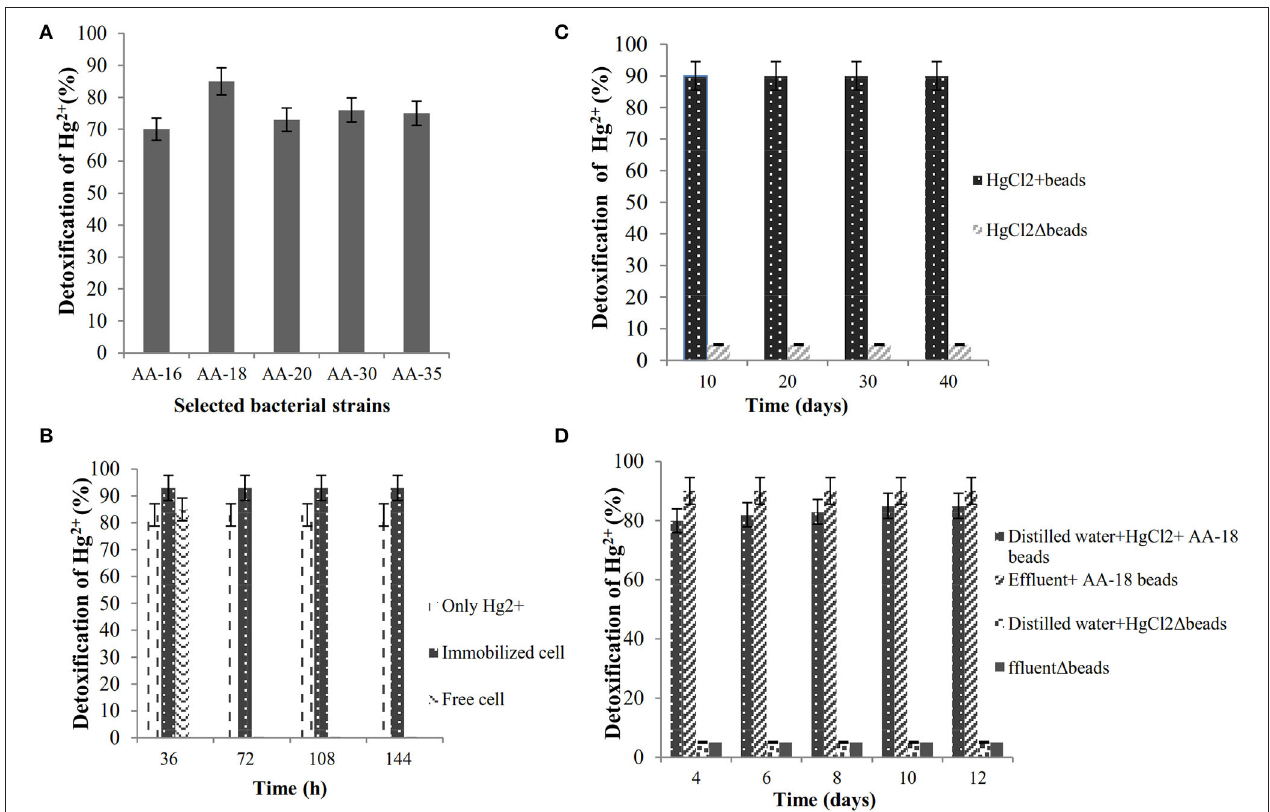
FIGURE 3 | SEM analyses of Hg 2 + detoxification in industrial wastewater (A) with beads of immobilized B. cereus AA-18 and (B) without beads of immobilized AA-18.